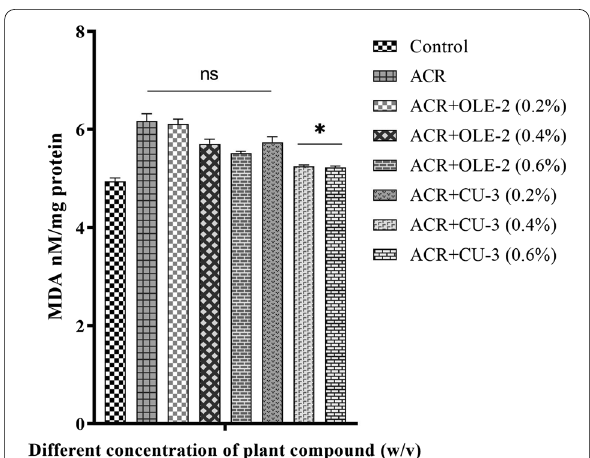
Fig. 9 AChE activity was more in ACR treated group. AChE activity of co-exposed ACR plant fraction flies compared with control and + treated groups. Plant fraction showed (OLE-2 and CU-3) significant decrease in the AChE activity expressed in nM/ min /mg protein. Statistical significance was an analysed by one-way ANOVA. Error bar SD. ± represents the Mean SD. The p value * p < 0.05 were considered as ± significant while comparing ACR treated group and co-exposed to plant fraction group + ACR plant fraction +